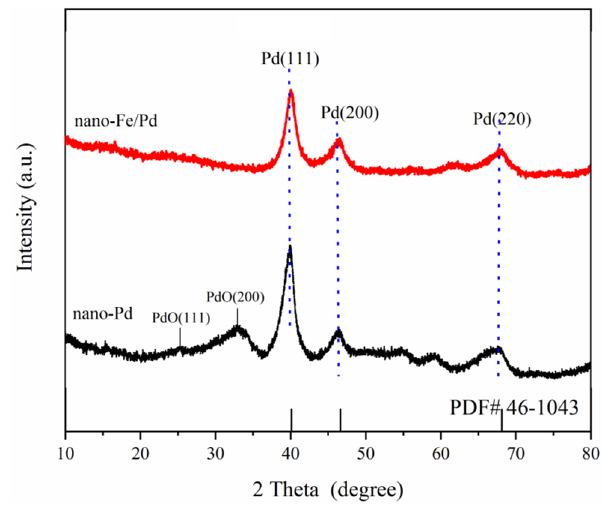
Figure 3. XRD patterns of nano-Fe/Pd and nano-Pd samples.